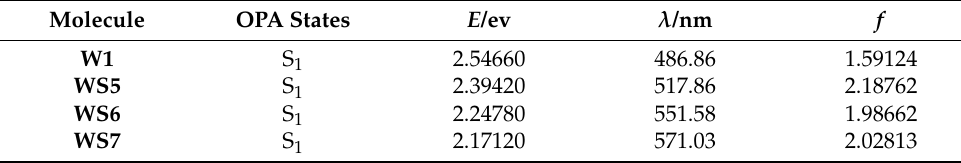
Table 1. Excited state information for the first excited state of the four molecules.